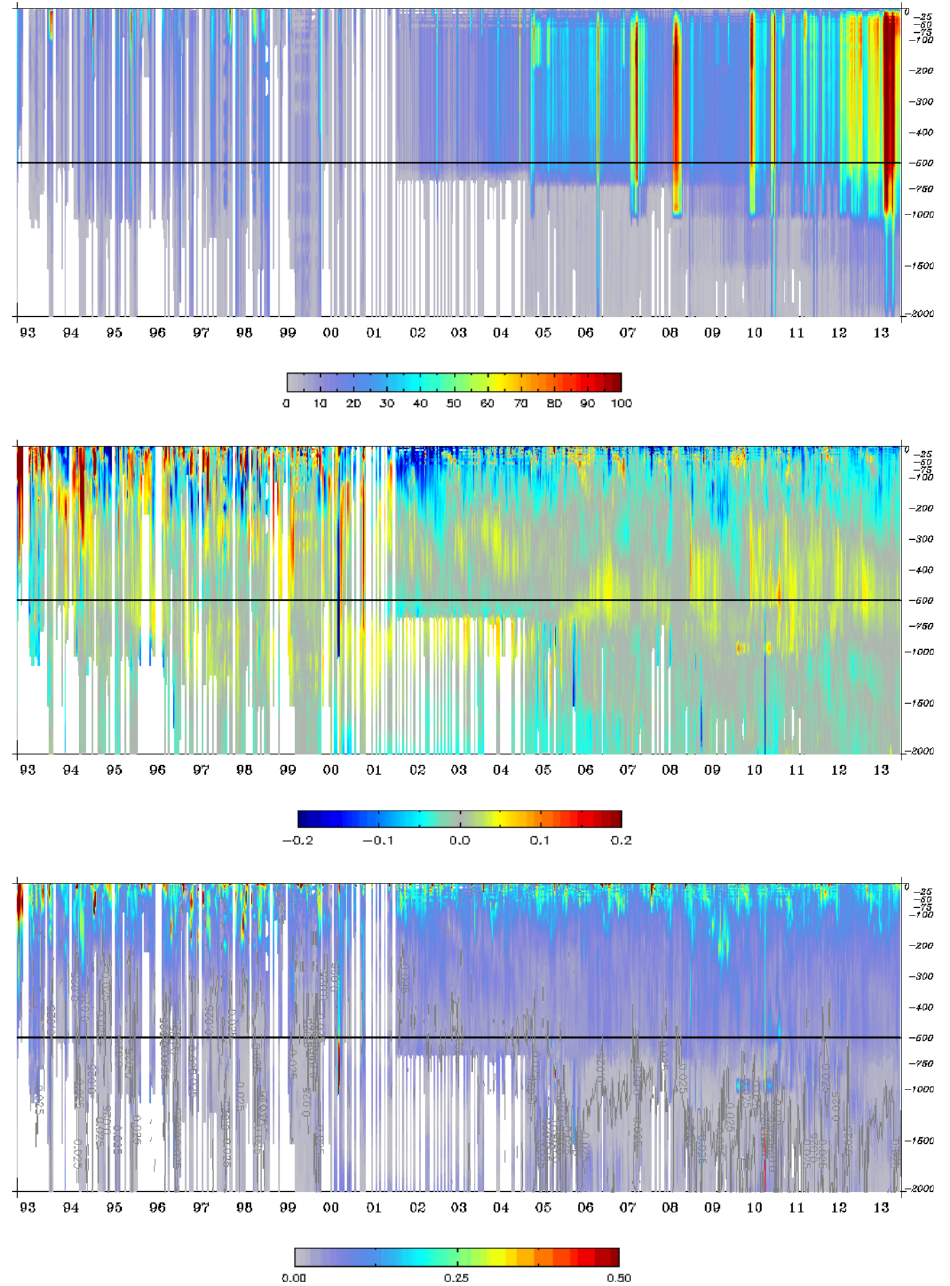
Figure 6. Evolution of weekly salinity data assimilation statistics from in situ profiles, function of the depth averaged over the whole Mediterranean basin : number of observations (top), mean innovation (middle) and rms of the innovation